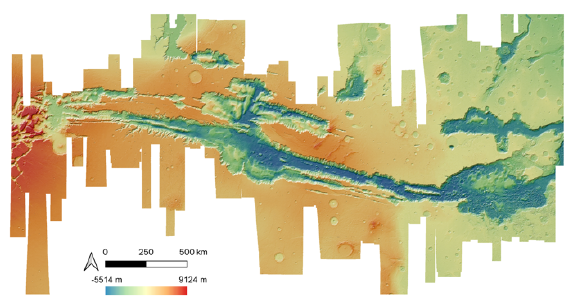
Figure 3. The final resulting HRSC DTM mosaic at 50m/pixel, covering the whole of Valles Marineris.